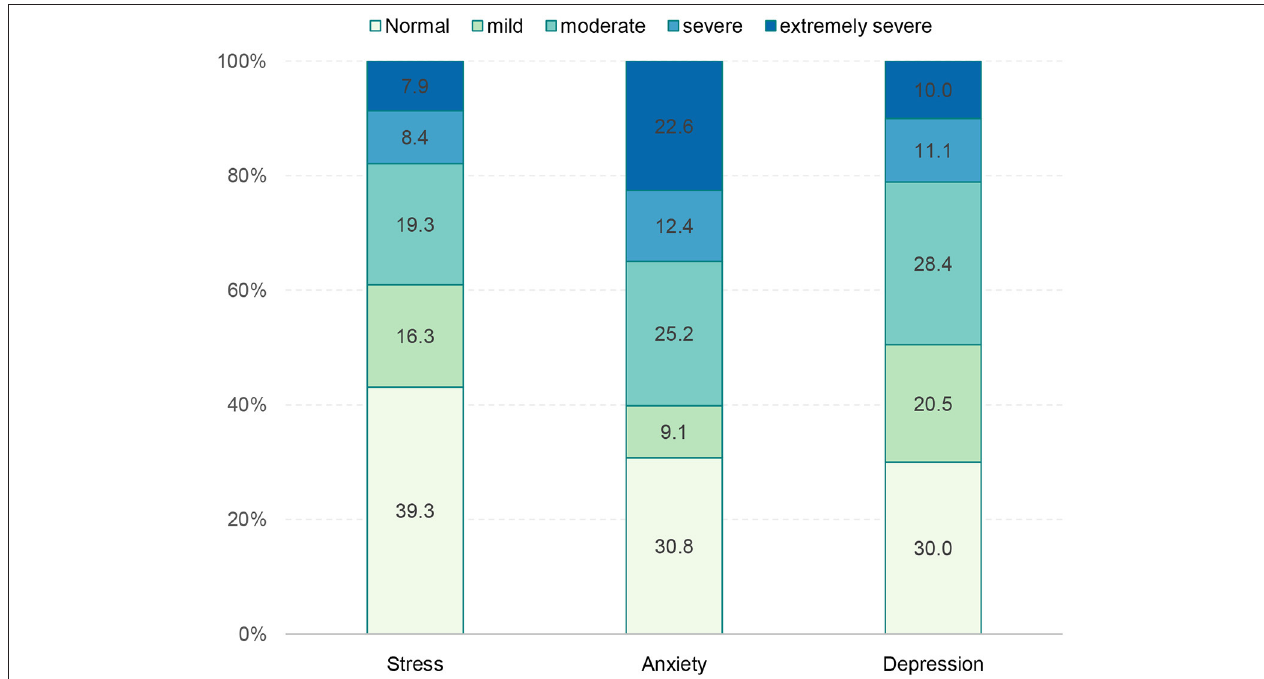
FIGURE 1 | Prevalence of depression, anxiety, and stress.